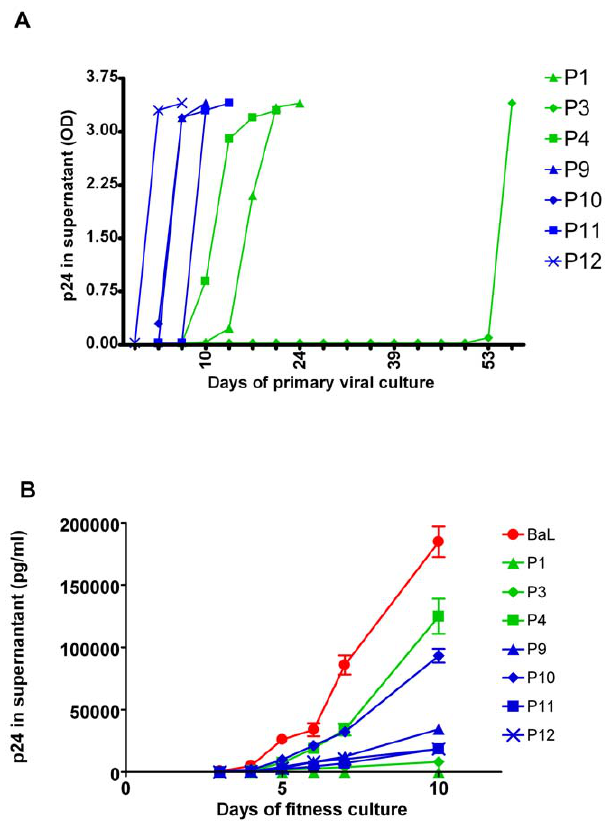
Figure 2. Replication characteristics of virus from secundary controllers. Ten million purified CD4 + T-cells from 4SC and 4SNC are cultivated with PHA and IL-2 stimulated PBMC. Panel A shows the virus replication in the primary culture (y-axis shows OD of p24 ELISA). These viruses were used in a secondary culture to evaluate fitness, by infecting new PHA and IL-2 stimulated PBMC at an equal MOI, with Ba-L virus as a reference. In panel B, the mean (and SEM) virus production in three donor PBMC is expressed as p24 in the supernatant. Green symbols are the SC; blue symbols are SNC and red symbol is BAL virus.